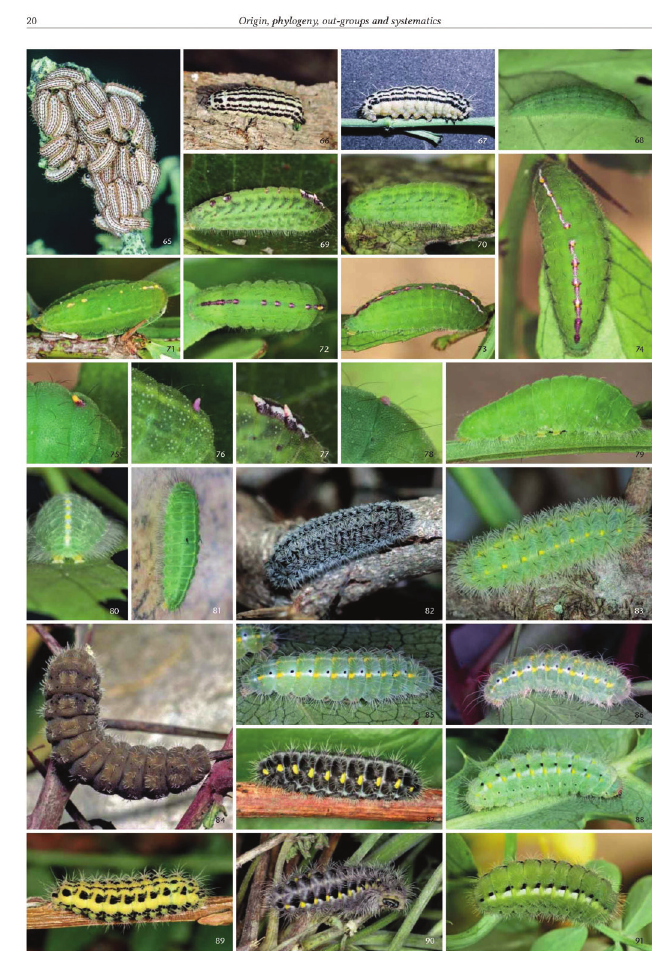
Figure 3. Larval diversity in burnet moths on page 20 of the